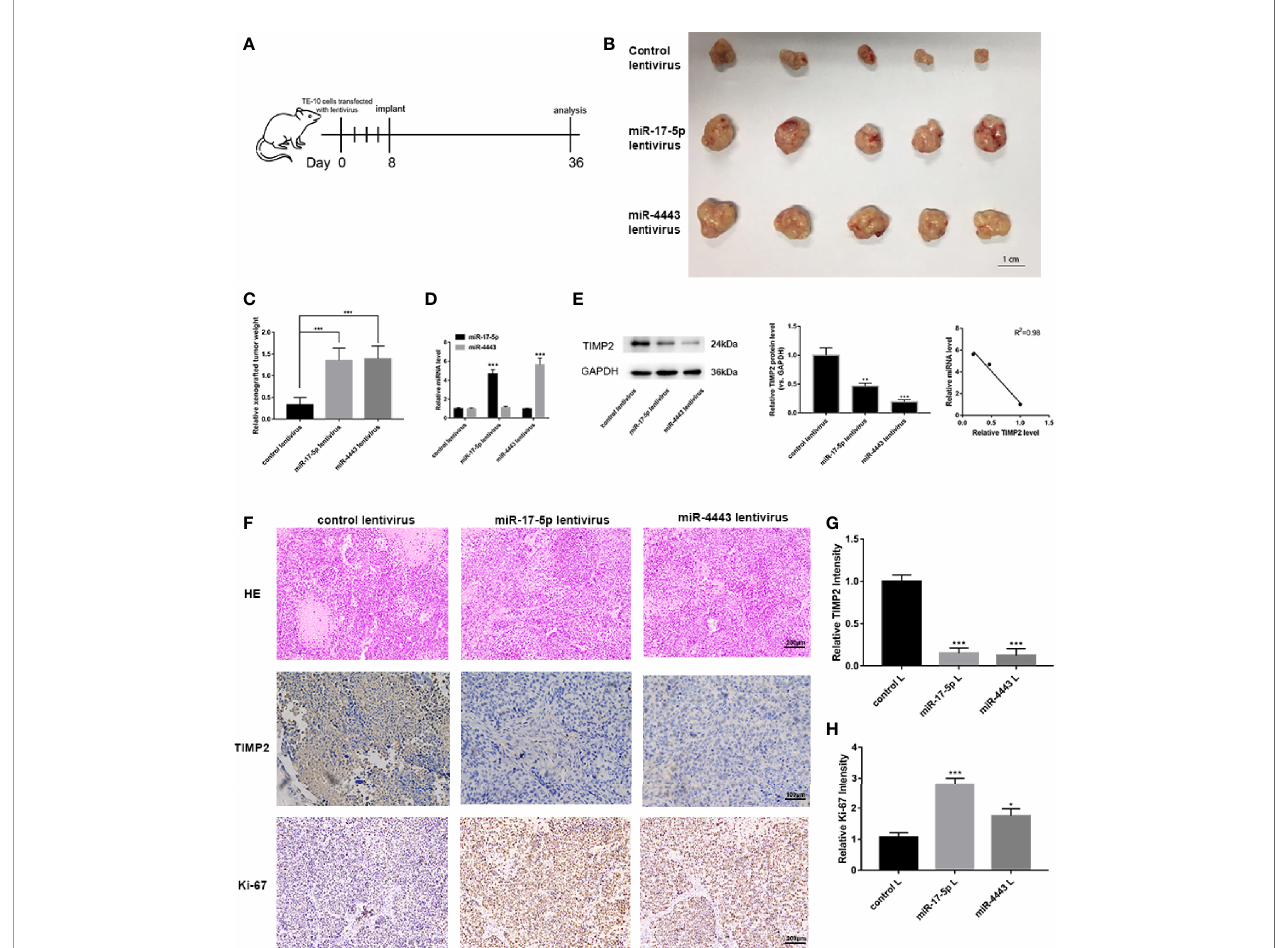
FIGURE 5 | In vivo experiments to verify the effects of miR-17-5p and miR-4443 on ESCC cells. (A) The fl ow chart of the whole in vivo experiments. (B) The morphology of the isolated tumors in each group (n = 5). (C) Quantitative analysis of the xenografted tumor weight. (D, E) qRT-PCR analysis of miR-17-5p/4443 (D) and western blot analysis of TIMP2 expression (E) , left and middle) in each group and their quanti fi cation; Pearson ’ s correlation scatter plot of the fold changes of miR-17-5p, miR-4443 and TIMP2 protein tumor tissues. (F) HE staining and immunohistochemical analyses of Ki-67 and TIMP2 in primary tumors (n = 5) derived from the different groups. (G, H) Quanti fi cation of Ki-67 and TIMP2 intensity in fi gure. All data are represented as mean ± SD. *P < 0.05, ***P <